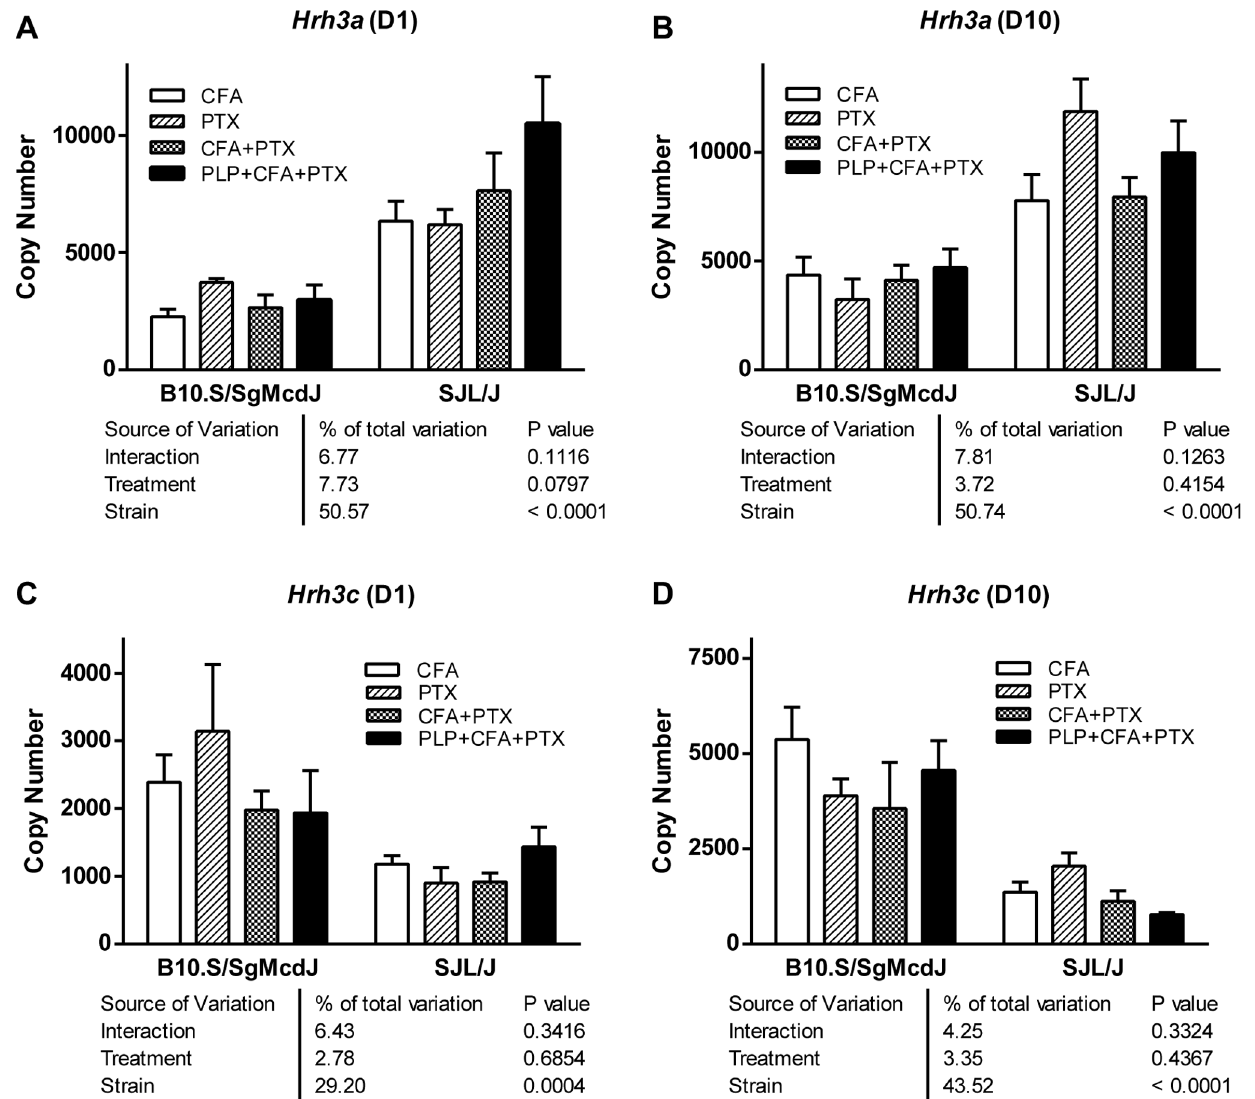
Figure 3. Hrh3 isoform expression is influenced primarily by strain. Expression levels were determined by real time PCR using mRNA isolated from perfused forebrains on D1 (A) and (C) and D10 (B) and ( ) post-injection with either CFA, PTX, CFA + PTX or PLP 139–151 + CFA + PTX, as described in Materials in Methods (n=4–8). Data were analyzed by two-way ANOVA for effect of treatment and strain.